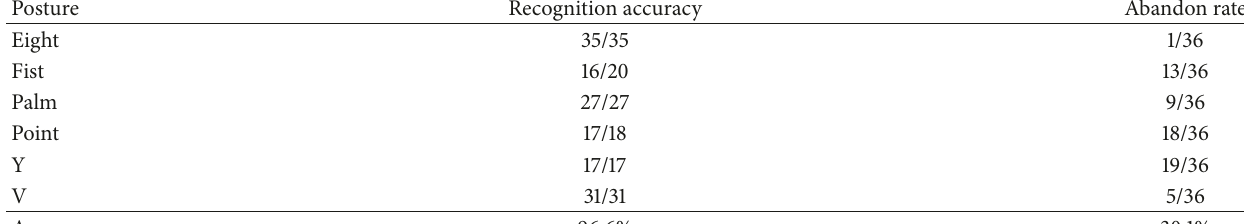
Table 9: Recognition result and abandon rate for the testing set.